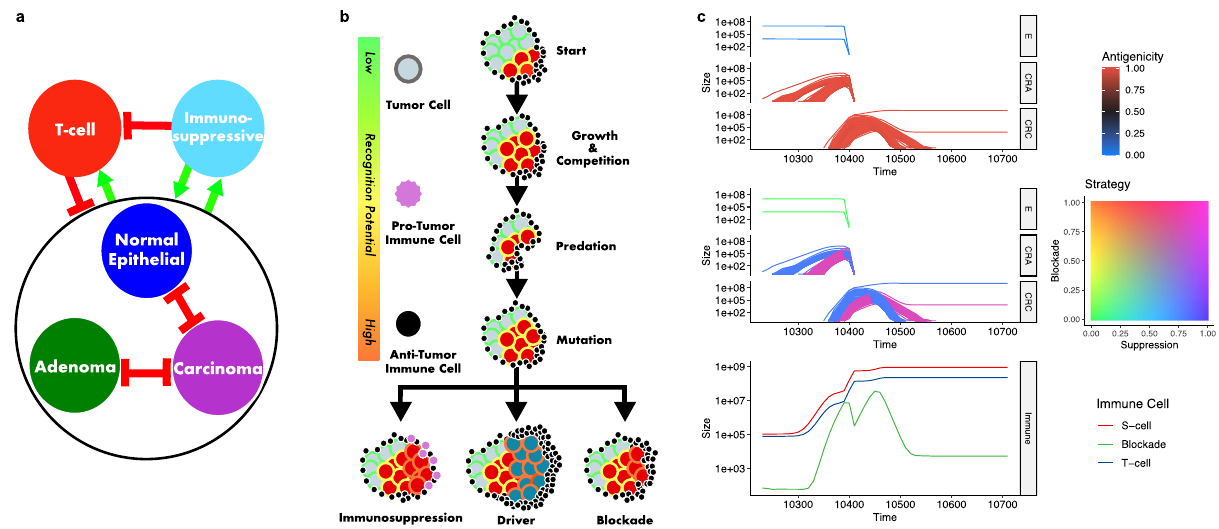
Fig. 2 The competition model in Eq. (1) was expanded to include mutation, allowing for simulation of evolution from pre-tumor epithelium (E) to adenoma (CRA) to carcinoma (CRC), with the possibility to acquire driver mutations and immune escape strategies (blockade or suppression). a This model simulates cell – cell competition, predation by cytotoxic T cells, mutualism between tumor cells and immunosuppressive cells, and reduction of T cell in fi ltration by immunosuppressive cells (amensalism). Red bars indicate inhibitory interactions while green arrows represent positive interactions. b The model is initiated with a large population of homogenous non-immunogenic epithelial cells. Mutation may occur during division, resulting in the creation of a new population that inherits all ancestral antigens and mutations from its parent. Each mutation is accompanied by the generation of a neoantigen, which stimulates increased attack by cytotoxic T cells at a rate proportional to the neoantigen ’ s randomly assigned recognition potential. With low probability, cells may also acquire one of three bene fi cial mutations: (1) the ability to recruit immunosuppressive cells, which decreases T cell attack while increasing growth rates; (2) the ability to block T cell attack, reducing immune kill; and (3) acquisition of driver mutations, which increase division rates and carrying capacities once enough have accumulated. If an epithelial population acquires two driver mutations it is considered an adenoma, which grows in a separate niche atop the epithelial tissue, limiting interactions between the two populations. CRA become carcinomas when they acquire four driver mutations in total. CRC has the ability to grow both atop and into the epithelium, allowing carcinomas to invade and destroy epithelial and adenoma clones. Due to inheritance, there may eventually be clones that accumulate multiple bene fi cial mutations. c Example simulation, where an E population evolved into a CRA after 1390 days, which in turn evolved into a CRC. The dominant CRC phenotype had a high antigenicity (top) and strong immunosuppression (middle), resulting in an increase in immunosuppressive cells and a drop in T cells (bottom). Over 200,000 phenotypes developed in this simulation, but only those populations with >50,000 cells are heterogeneity (aITH) in a subset of n = 16 cases (160 exomes, as each was downsampled 10 times to normalize depth, for n = 6